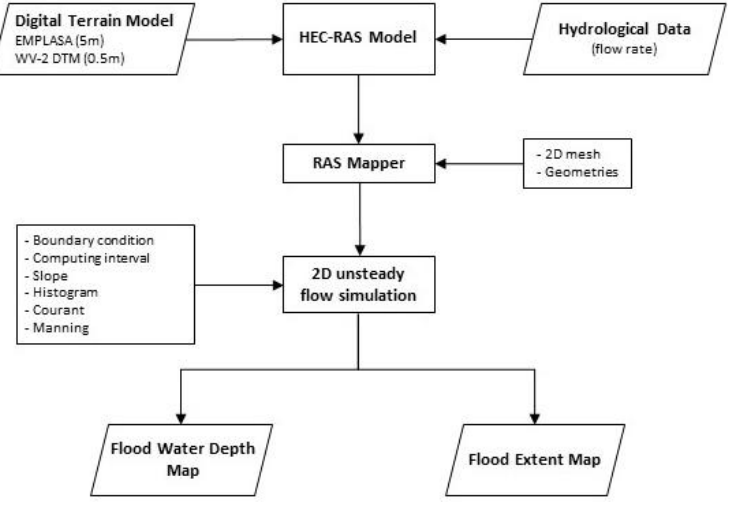
Figure 5. Methodological flowchart.